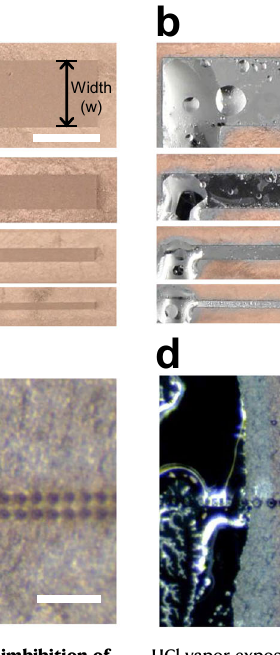
the small droplets on the surface after imbibition are water through the reac- tion between gallium oxide and HCl vapor. No signi fi cant effect of water for- mation on the wetting was observed. The water could be easily removed by a simple drying process.